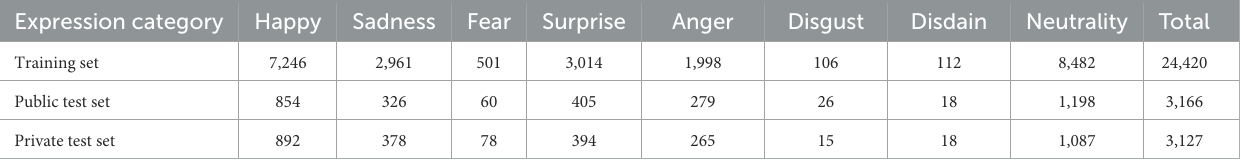
TABLE 2 Distribution of expression categories in the FERPlus